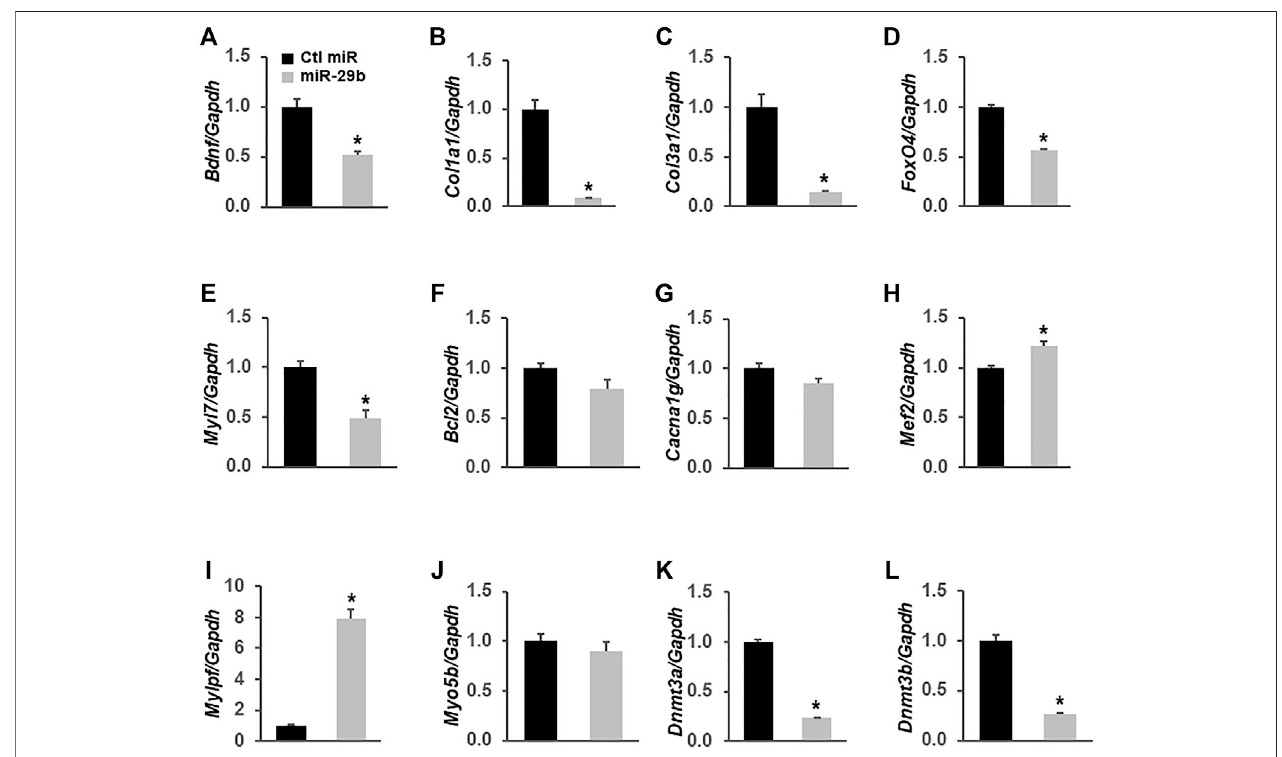
FIGURE 6 | miR-29b modulates the expression levels of multiple genes related to heart function in H9c2 cells. miR-29b or negative control miRNA was overexpressed in H9c2 cells by transient transfection. TaqMan-based RT-qPCR was performed to determine the expression levels of Bdnf (A) , Col1a1 (B) , Col3a1 (C) , Fox O 4 (D) , Myl7 (E) , Bcl2 (F) , Cacna1g (G) , Mcf2 (H) , Mylpf (I) , Myo5b (J) , Dnmt3a (K) , and Dnmt3b (L) . Gapdh served as an internal control. n = 3 independent experiments. * p < 0.01 vs. negative control miRNA (Ctl